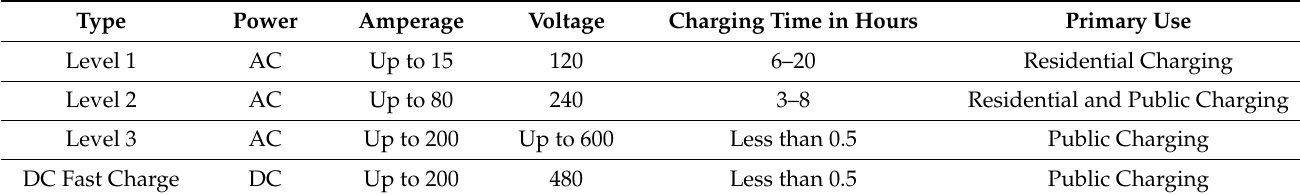
Table 1. Classification of chargers for